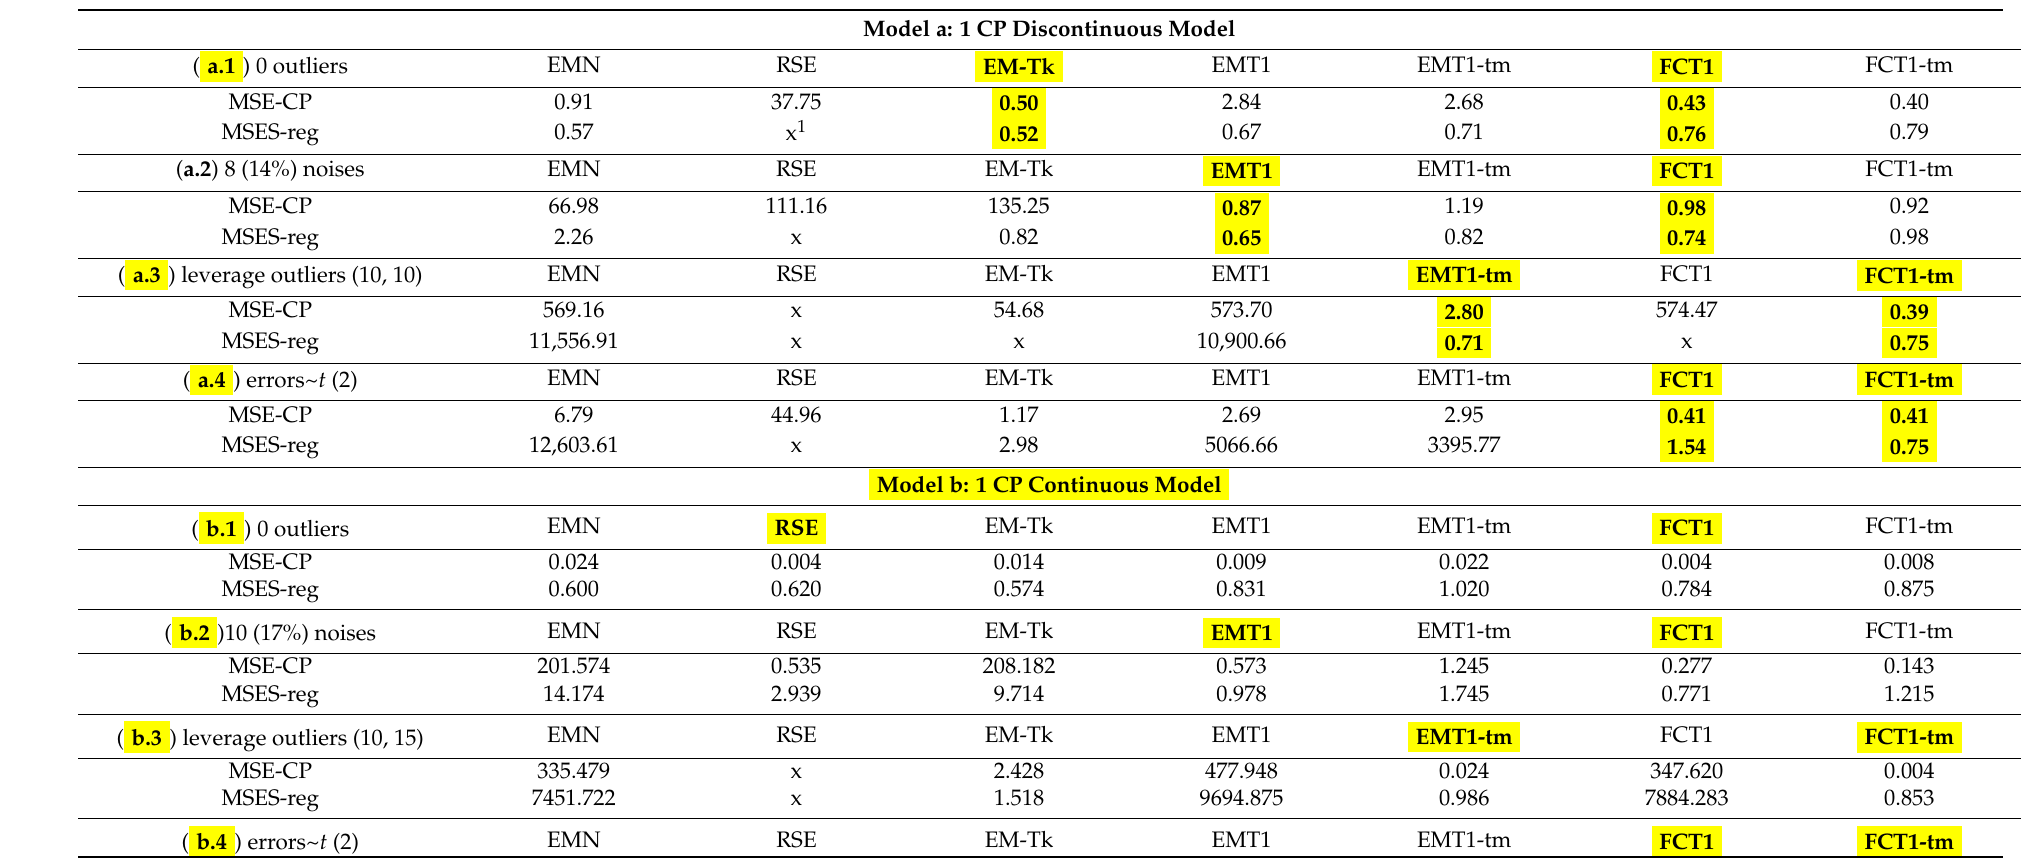
Table 2. Comparisons of 7 methods with models a–c under 4 different situations, respectively. Model a: 1 CP Discontinuous